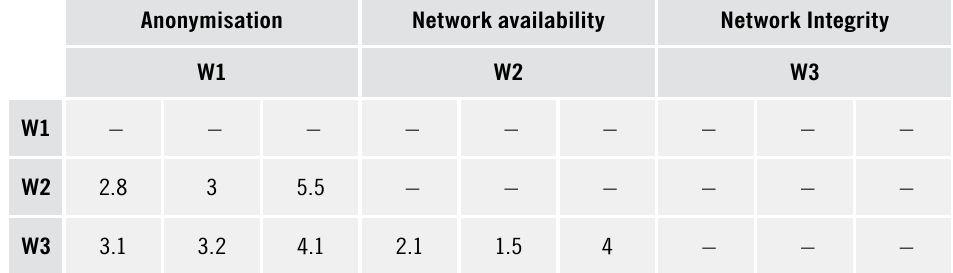
Table 5. Paired comparison matrix of security sub-criteria of the network, based on experts opinions